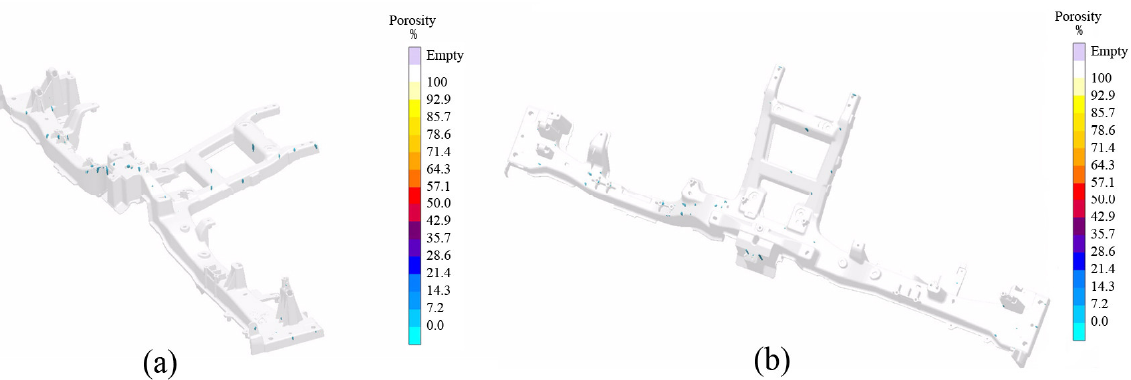
Figure 9. Comparison of shrinkage cavity rate before and after optimization: ( a ) before optimization; ( b ) after optimization.